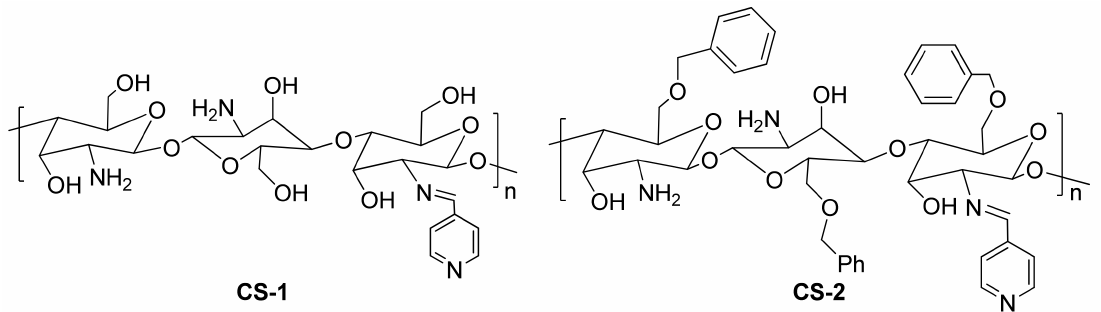
Figure 4. Typical chemical structures of chitosan-based inhibitor: CS-1 and